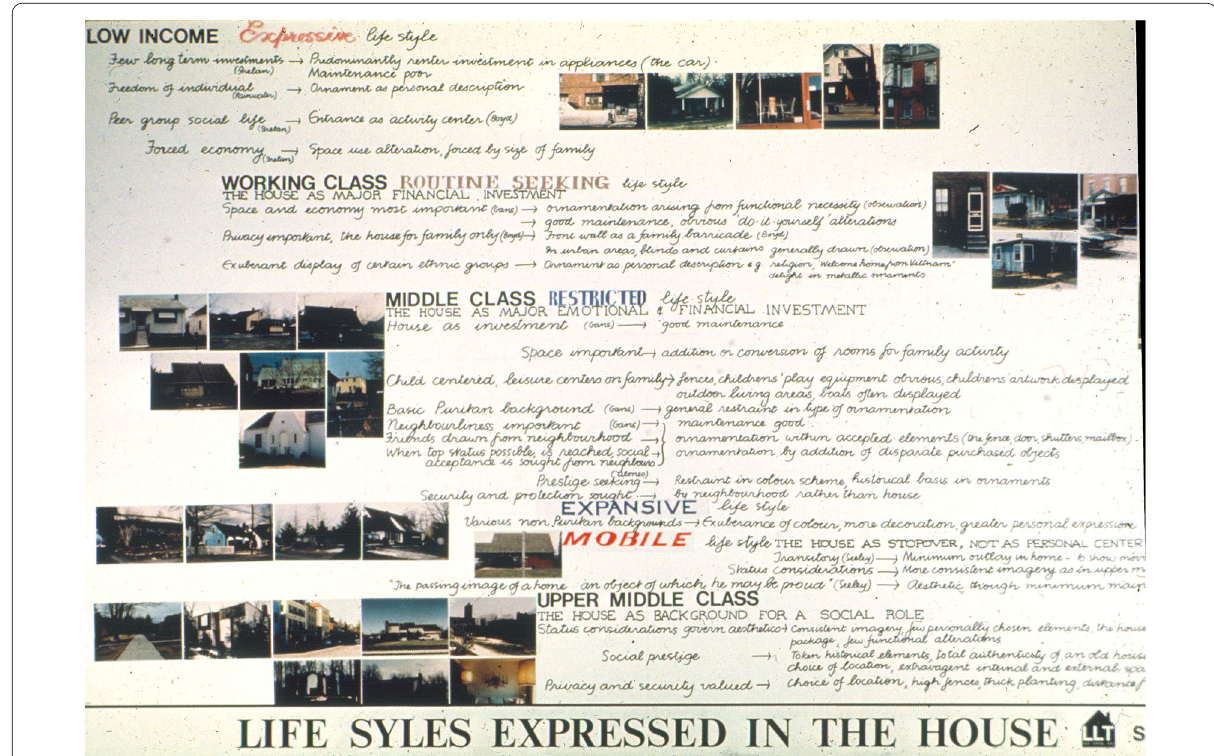
Fig. 4 Robert Venturi, Denise Scott Brown, and Steven Izenour, learning from Levittown Studio, Fall 1970. Life styles expressed in the house. Credits: Venturi, Scott Brown Collection, The Architectural Archives, University of Pennsylvania. https:// www. design. upenn. edu/ archi tectu ral‑ archi ves/ ventu ri‑ scott‑ brown‑ and‑ assoc